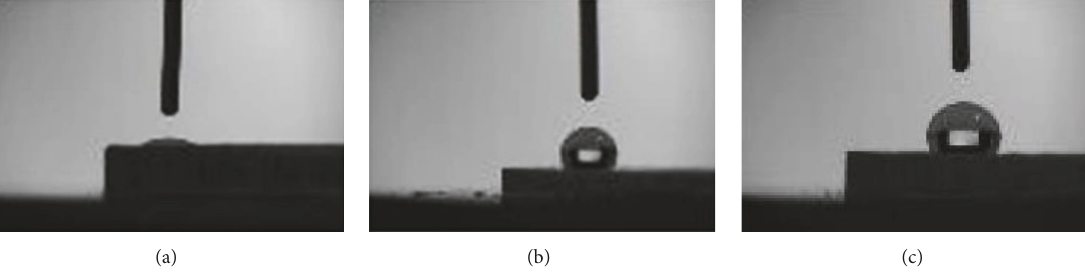
Figure 2: Microscopic image of wet contact angle of TiO 2 . (a) Wet contact angle of TiO 2 , (b) wet contact angle of modified TiO 2 with sodium stearate, and (c) wet contact angle of modified TiO 2 with sodium oleate.